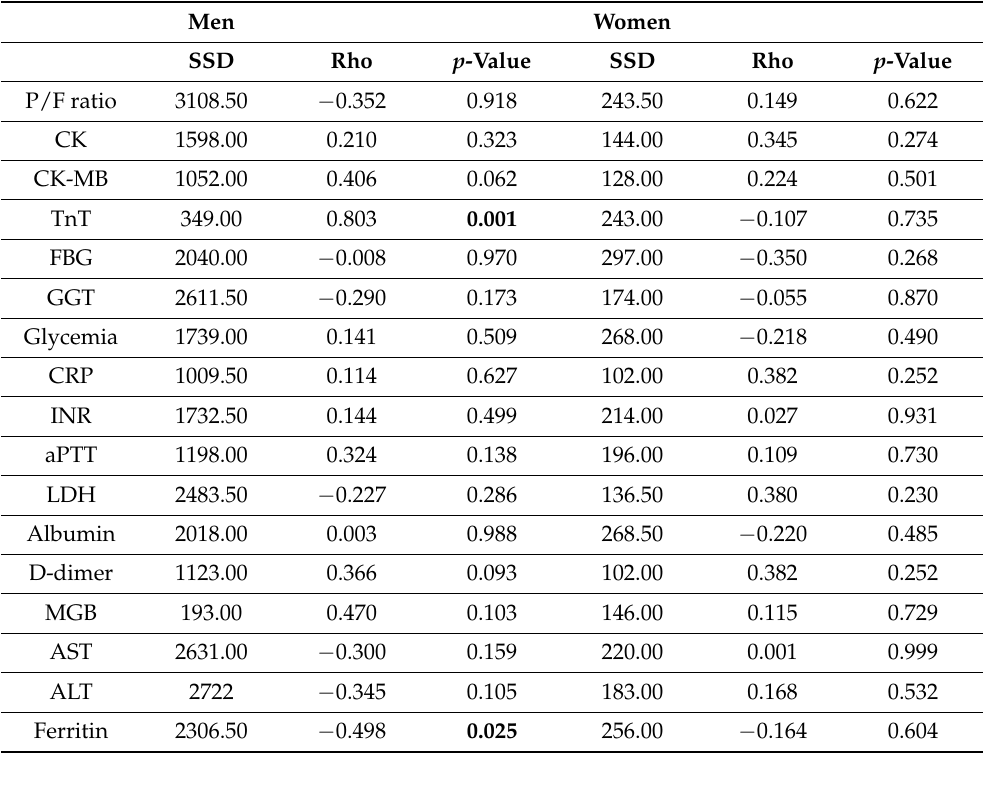
Table 7. Spearman Correlation values for the age parameter in the deceased group. Significant scores are shown in bold.